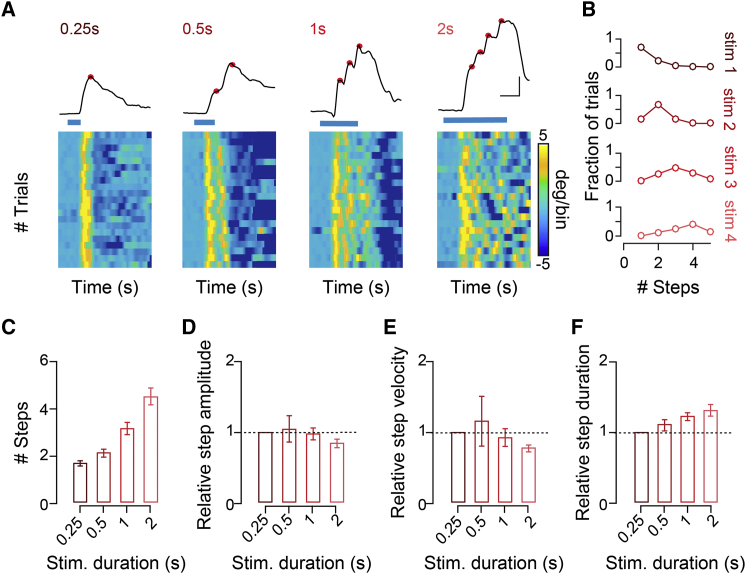
Pitx2ON Neurons-Dependent Head Movements Are Characterized by Stepwise Kinematics(A) Kinematics of head displacements in the yaw dimension for increasing duration of blue-light stimulation (0.25, 0.5, 1, and 2 s); note representative stepwise trajectories and deflection points (red dots) for prolonged stimulations (top). Trial-by-trial identification in derivative space of the deflection points giving origin to the stepwise kinematics (bottom), aligned by the onset of the first movement. High values (yellow colors) indicate sudden acceleration marking the onset of a head motion bout (scale bar: 500 ms, 10 degrees; time bin: 20 ms).(B) Fraction of trials presenting a given number of steps for progressively longer stimulus duration (data shown in B are examples from one representative animal).(C–F) Average number of steps (C), step amplitude (D), velocity (E), and duration (F) for increasing stimulus duration across all animals relative to their characteristic vector generated with a 250 ms light stimulus (nTRIALS/MOUSE = 60; nMICE = 12; pAMPLITUDE = 0.60; pVELOCITY = 0.58; pDURATION = 0.06). All results are presented as mean ± SEM.See also Figure S6.